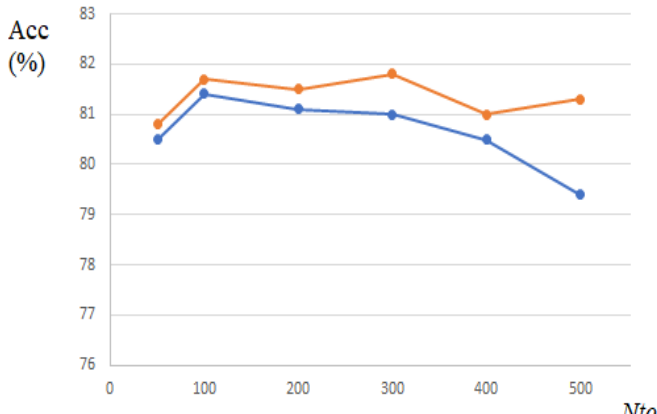
Figure 7. Testing accuracy obtained by different numbers of filters, for English ( red ) and Italian ( blue ).